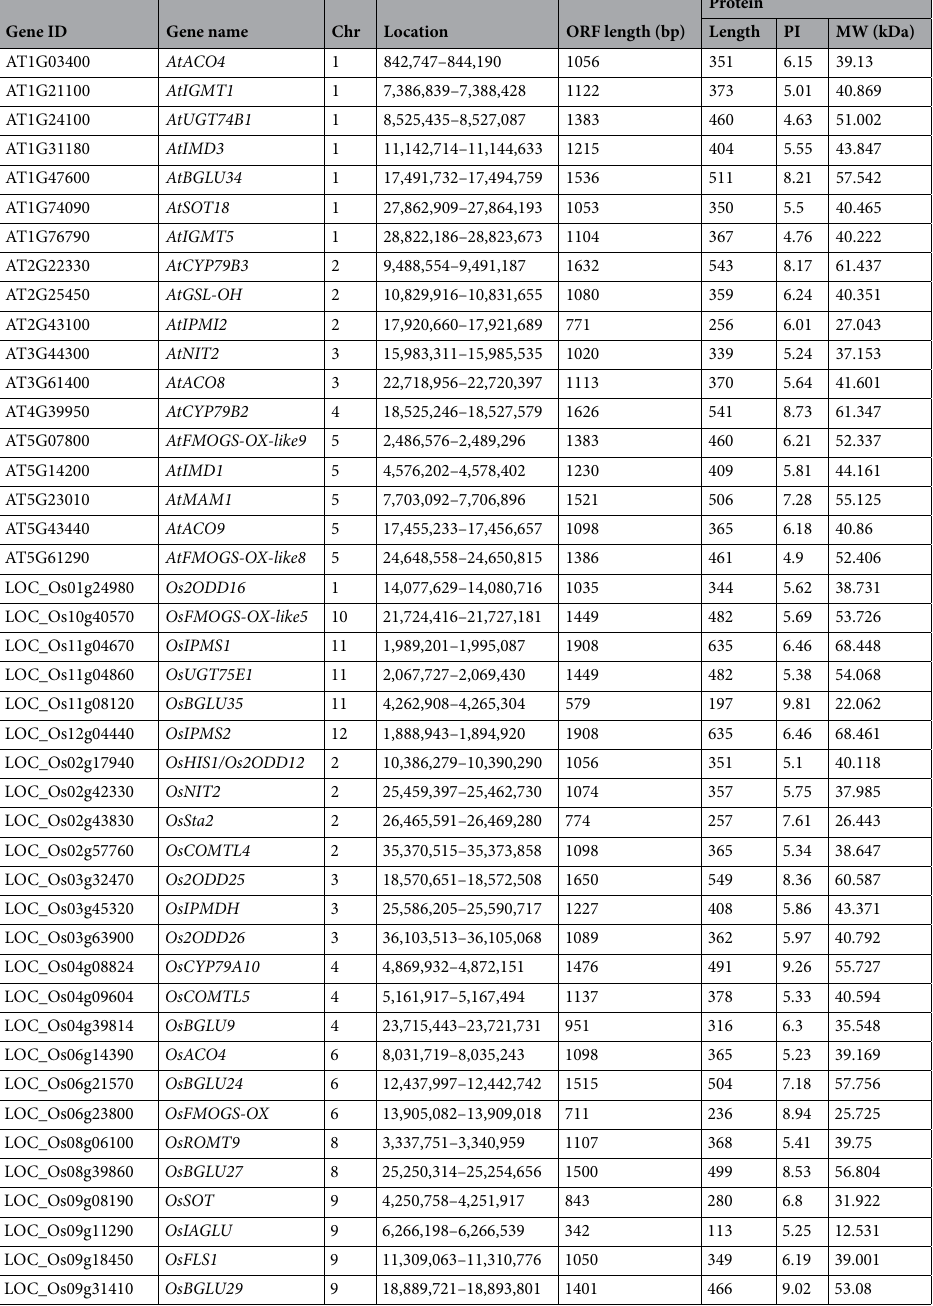
Table 2. Sulfur-encoding biosynthetic gene, chromosomal and protein level description in Arabidopsis and rice. Each gene is characterized according to its chromosome number, chromosomal loci, open reading frame (ORF) and physical characteristics of the encoding